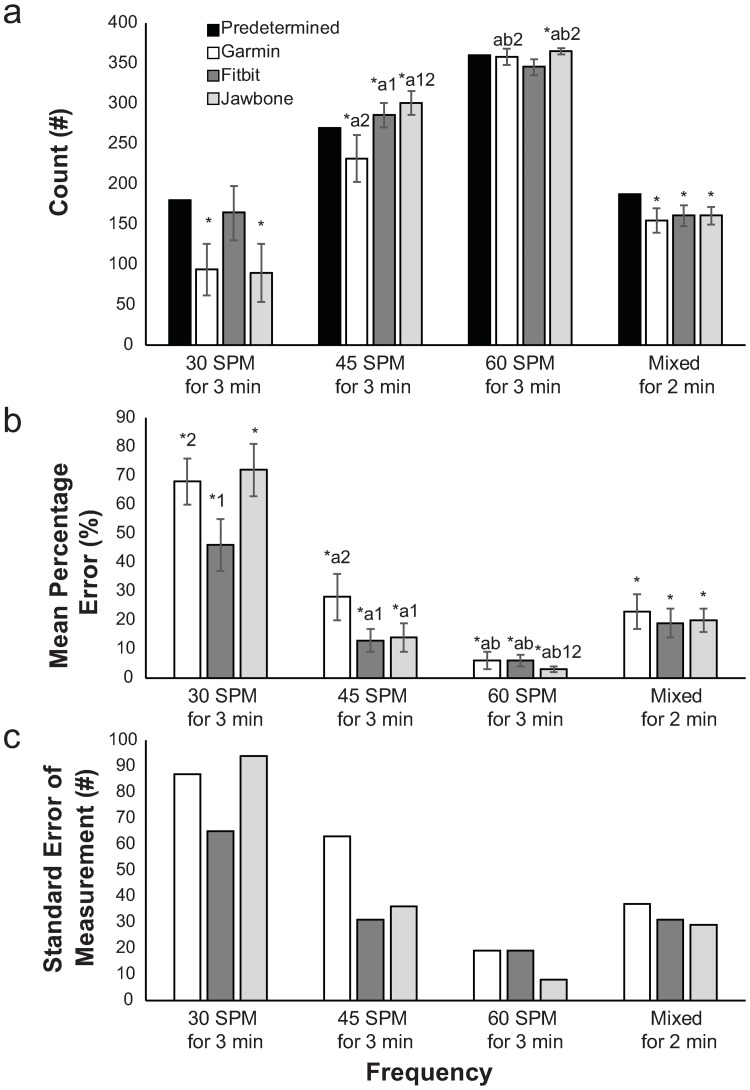
Wheelchair rollers task statistics.Means and 95%CI for (a) counts, (b) mean percentage error, and (c) standard error of measurement. Significant difference (p≤.05) *from Predetermined, afrom 30 spm, bfrom 45 spm, 1from Garmin, 2from Fitbit.